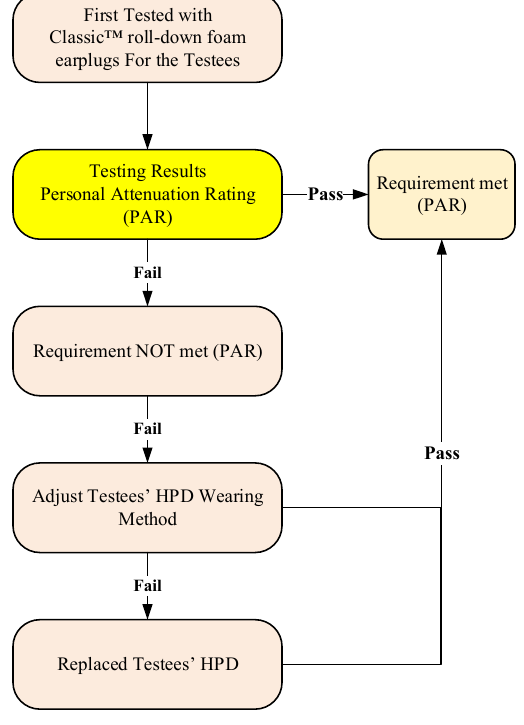
Figure 5. An example where the test result of the PAR value was “pass” after additional instructions and a different type of HPD were provided, followed by a re-test of the adaptability with the new Figure 3. The flowchart of the evaluation process for the 3M ™ EA-RfitTM HPD adaptability evaluation Figure 3. The flowchart of the evaluation process for the 3M™ EA-RfitTM HPD adaptability HPD. system applied in this study. evaluation system applied in this study.